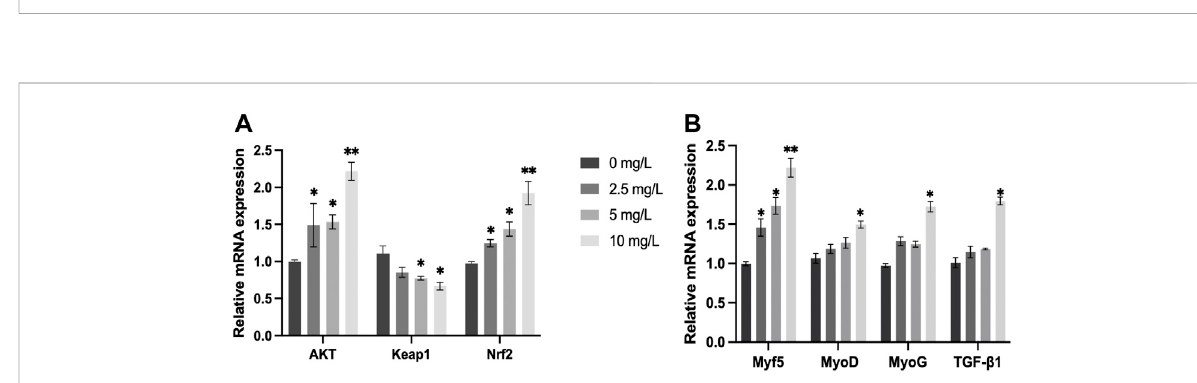
FIGURE 10 The effect of increasing concentrations of quercetin exposure on the relative expression of the (A) : AKT, Keap1 and Nrf2 genes and (B) : Myf5, MyoD,MyoG,andTGF- β 1genesinthemuscletissueof O.potamophila after21d.ThebarsindicatetheMean±SD( n =3).Statisticalsigni fi cancewas taken as *( p < 0.05) and **( p < 0.01) compared with the